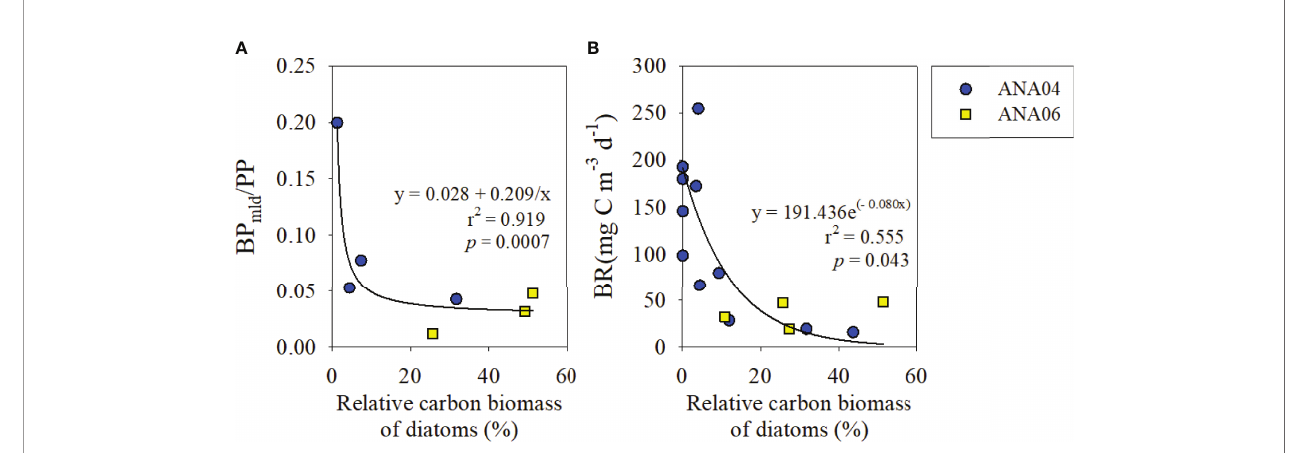
FIGURE 6 | The relationship between the mixed-layer depth integrated BP to PP ratio and relative carbon biomass of diatoms (%) (A) , and the relationship between BR and relative carbon biomass of diatoms (%) (B) . PP data were adopted from Lim et al.